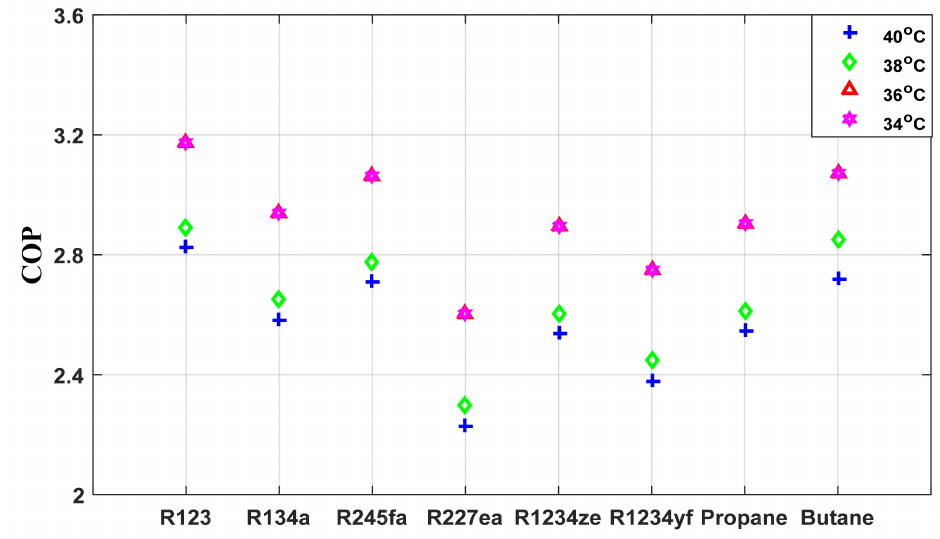
Figure 5. The coefficient of performance for a set of temperature values for refrigeration working